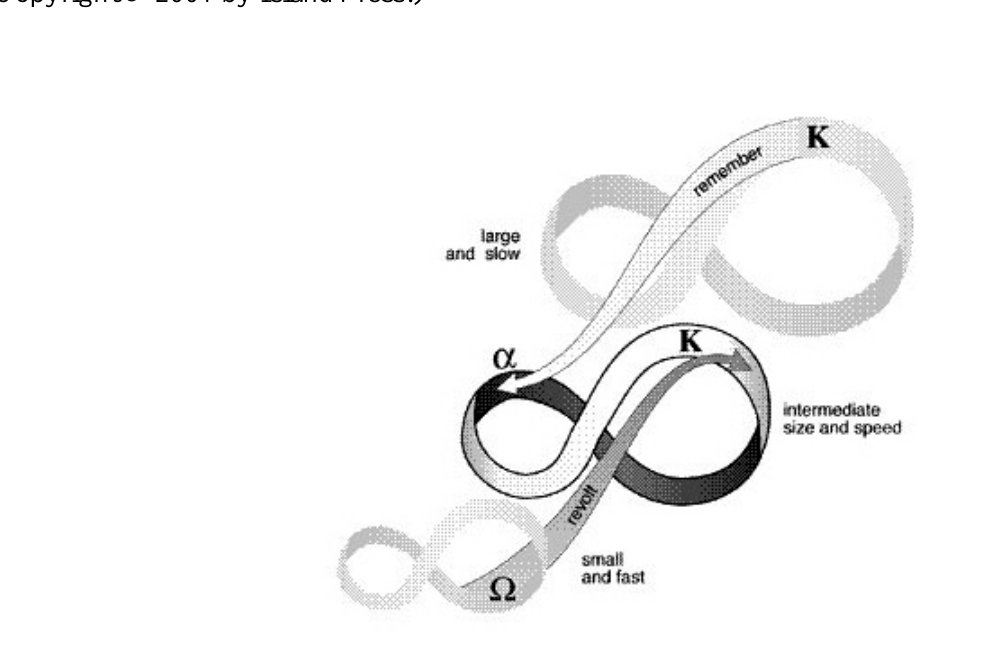
Fig. 1. A panarchy. Three selected levels of a panarchy are illustrated, to emphasize the two connections that are critical in creating and sustaining adaptive capability. One is the “revolt” connection, which can cause a critical change in one cycle to cascade up to a vulnerable stage in a larger and slower one. The other is the “remember” connection, which facilitates renewal by drawing on the potential that has been accumulated and stored in a larger, slower cycle. The number of levels in a panarchy varies, is usually rather small, and corresponds to levels of scale present in a system. (Excerpted from L. H. Gunderson and C. S. Holling, editors. Panarchy: understanding transformations in human and natural systems. Copyright © 2001 by Island